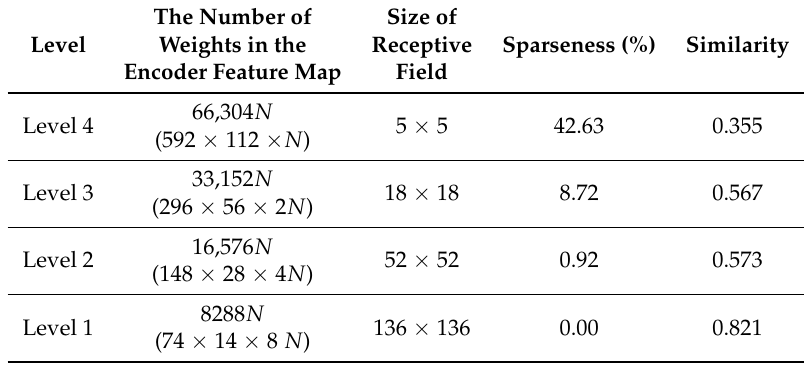
Table 1. Summary of Information at Each Level of Encoder of the Conventional